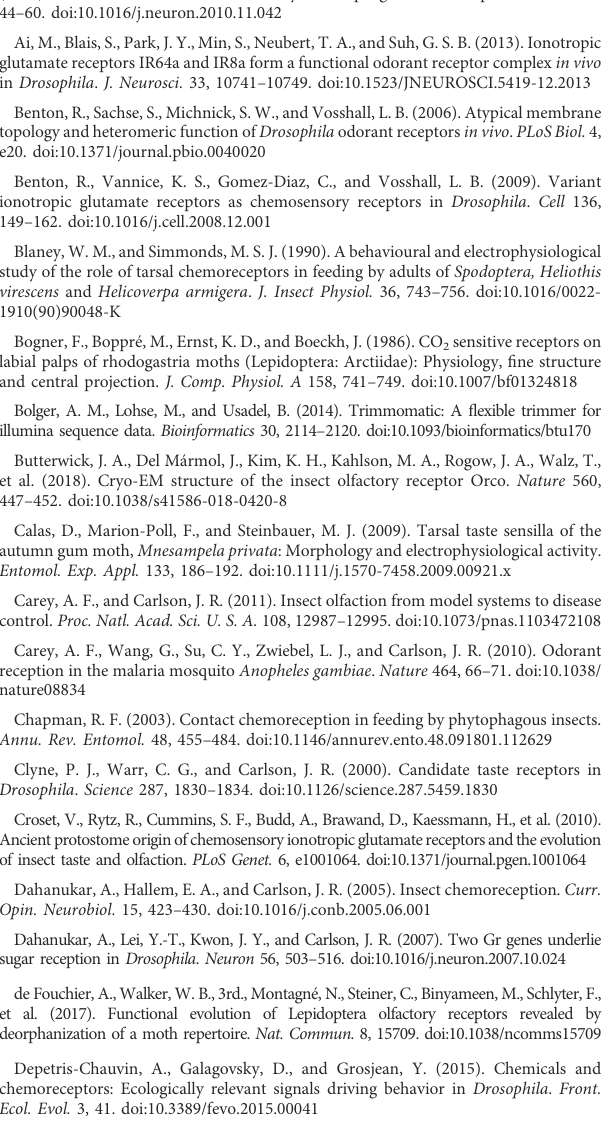
Homologous species distribution in Nr database. SUPPLEMENTARY FIGURE S2 Functional annotation of the transcripts based on GO